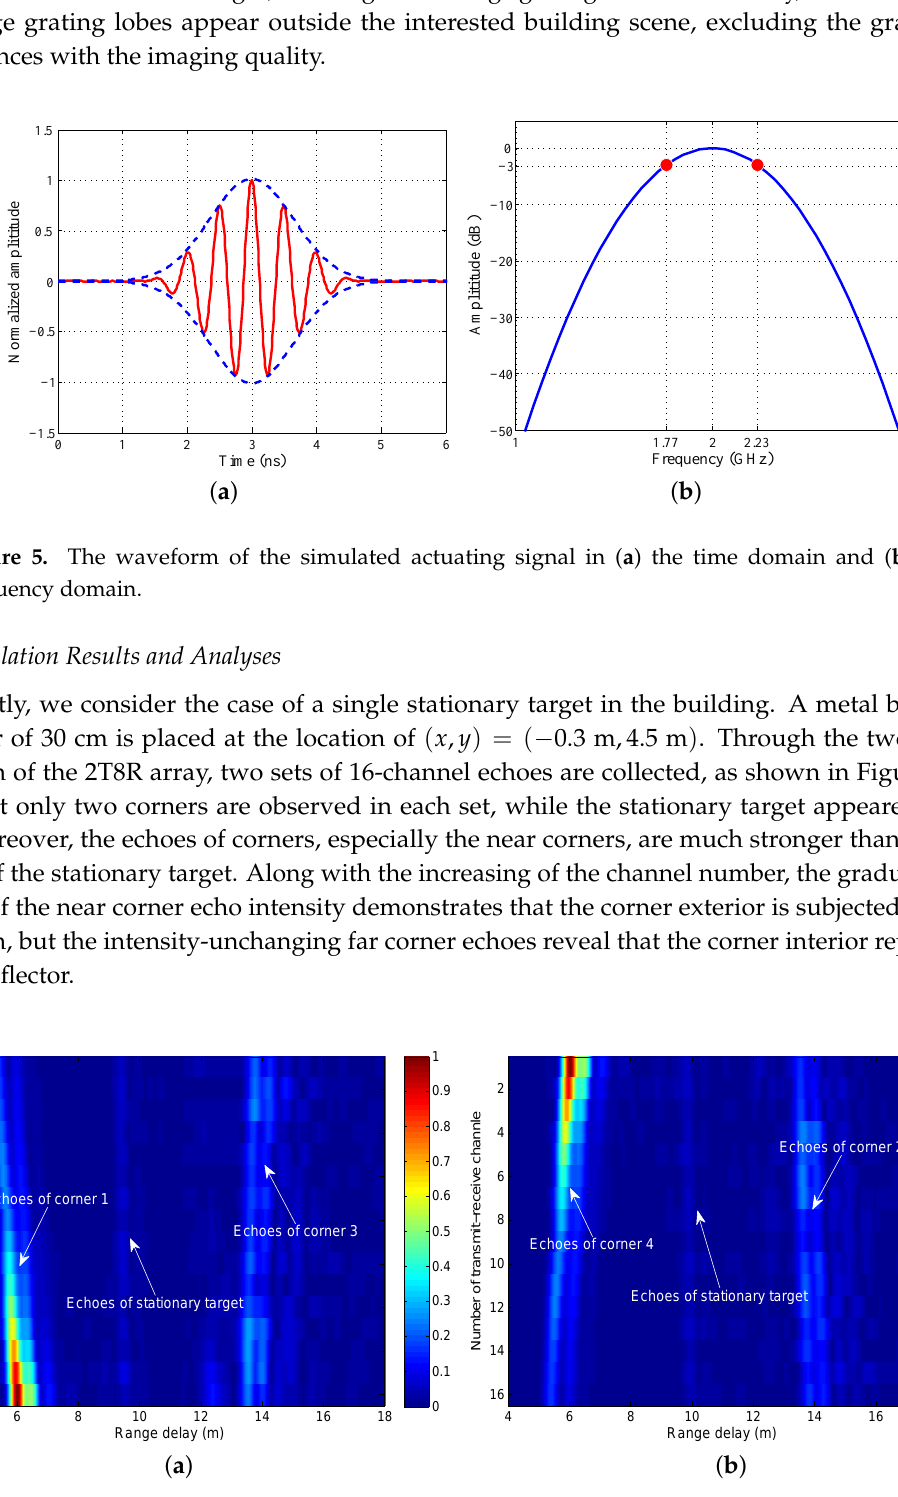
Figure 6. The range profile planes corresponding to ( a ) Location A and ( b ) Location